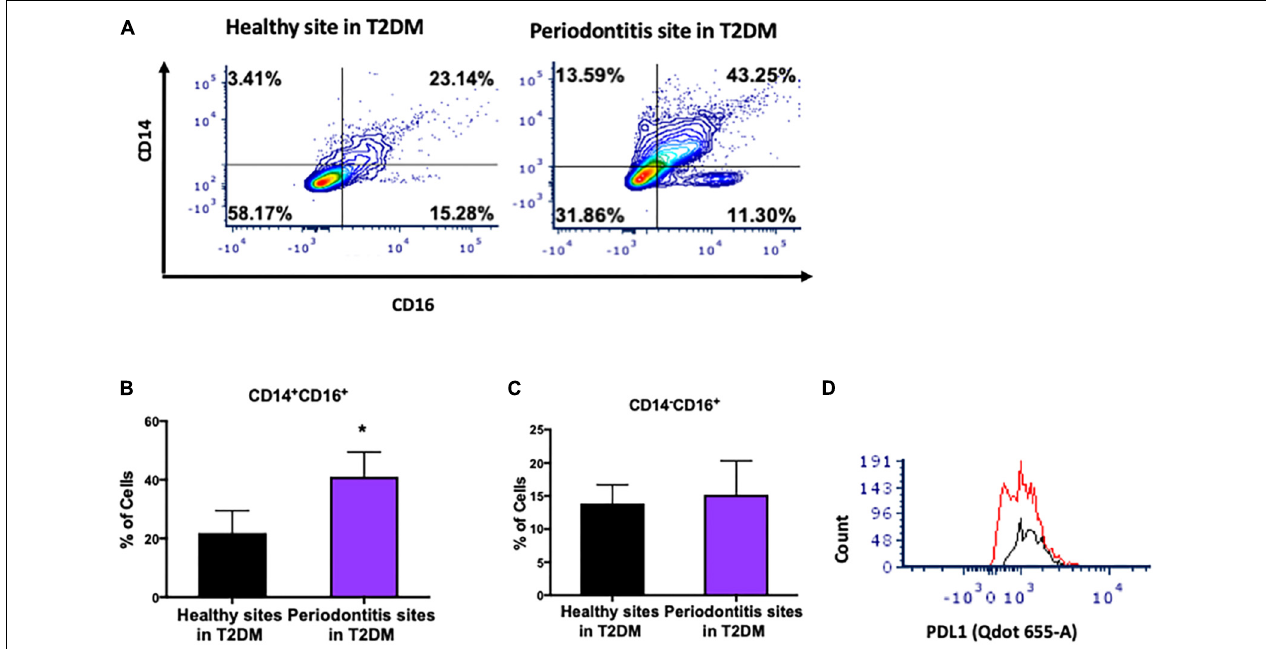
FIGURE 4 | Single cell suspensions from matched periodontitis-affected and healthy gingival tissues harvested from patients with T2DM were prepared and stained for UV Zombie, CD45, Lin (B220, CD19, Gr1 and Ter119), HLA-DR, CD16, CD14. (A–C) Representative counter plots of intermediate (CD14 + CD16 + ) and non-classical monocytes (CD14 − CD16 + ). Frequency of intermediate monocytes was significantly higher in periodontitis-affected tissue compared to matched controls ( n = 6; p < 0.05). (D) Flow cytometry histogram of CD47 (FITC) and PDL1 (Qdot655-A) expression in M2 macrophages in periodontitis-affected tissue (red line) compared to the healthy tissue (black line) shows higher PDL1 expression in periodontitis affected sites in T2DM (the symbol “*” indicates p < 0.05 compared to the healthy